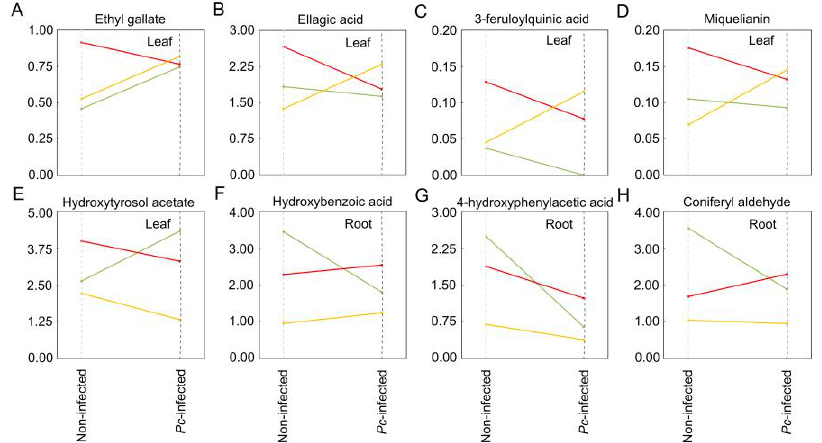
Figure 6. Phenolic compounds of Castanea sativa plants that showed different changes in their content in response to Phytophthora cinnamomi infection and the scenario plants were exposed to before inoculation (significant Pc × scenario interactions in Table 4; p < 0.05). Phenolic content was obtained at day 10 after inoculation in plants previously exposed to ambient temperature (green lines), high ambient temperature (orange lines) and two heat waves (red lines).